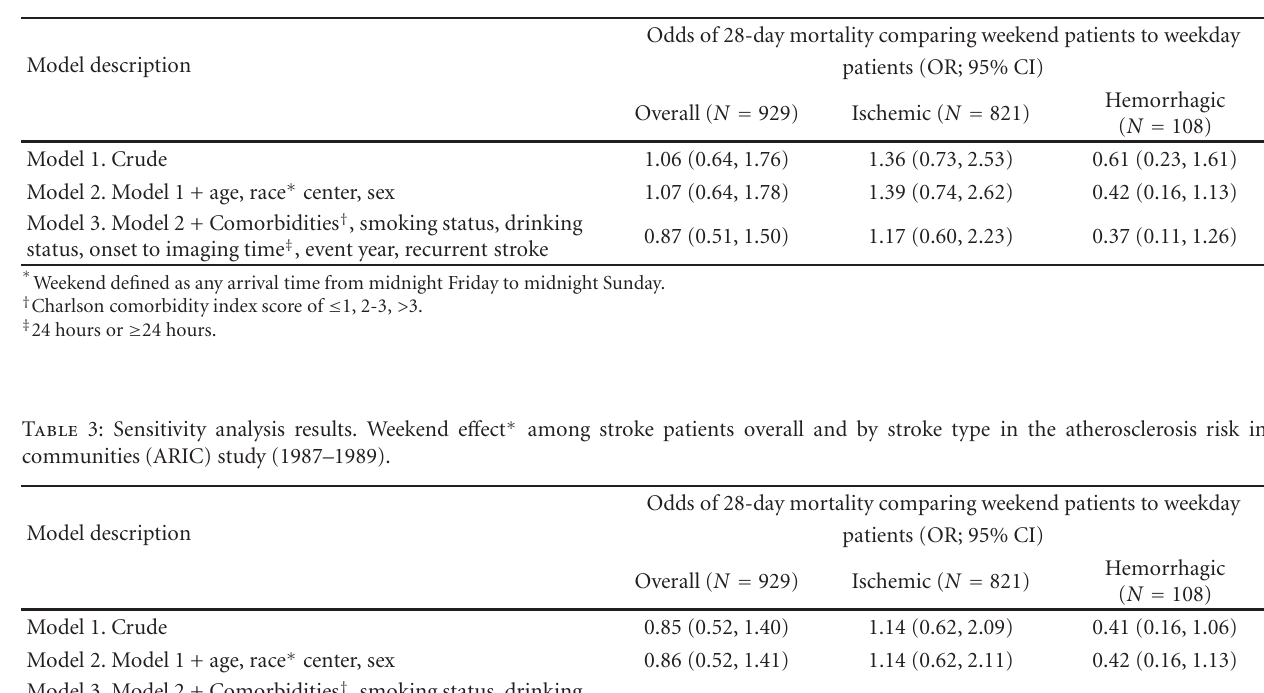
Table 2: Logistic regression results. Weekend e ff ect ∗ among stroke patients overall and by stroke type in the atherosclerosis risk in communities (ARIC) study (1987–1989).